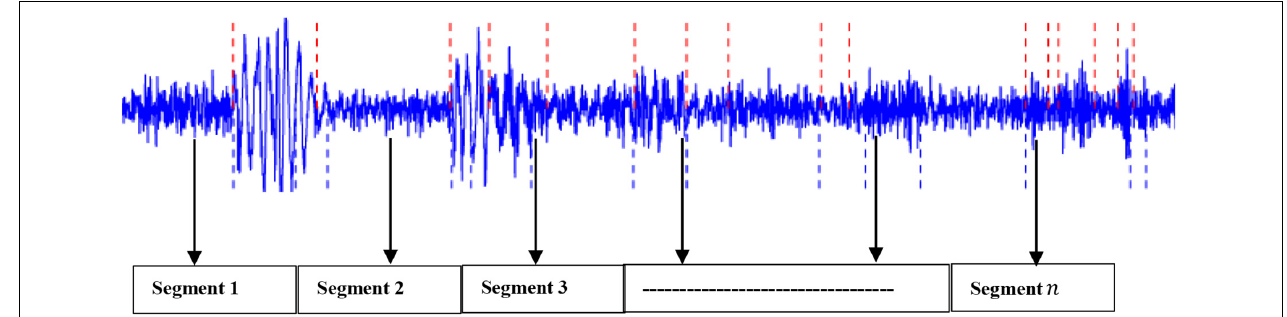
FIGURE 2 | An example of EEG being partitioned into